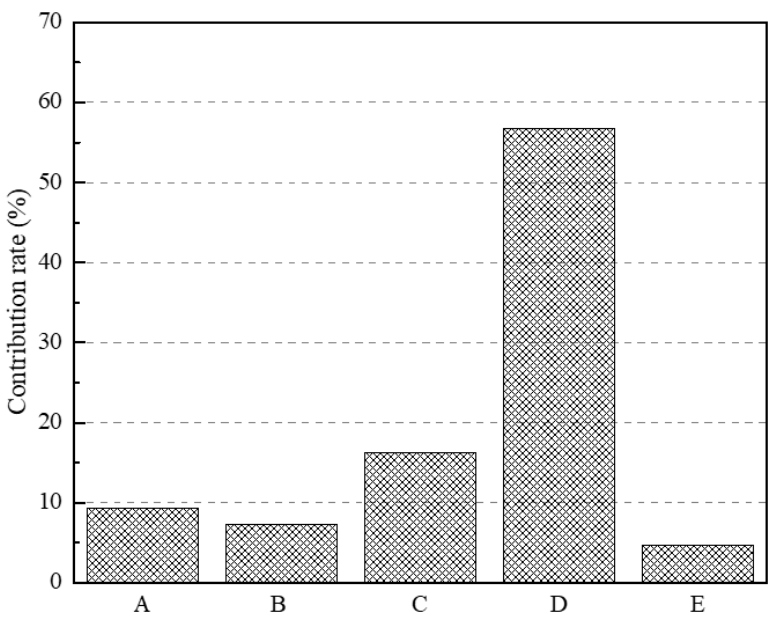
Figure 15. Contributions of each factor to the exergy of air outlet recovery. Table 11. ANOVA for the pressure drop.